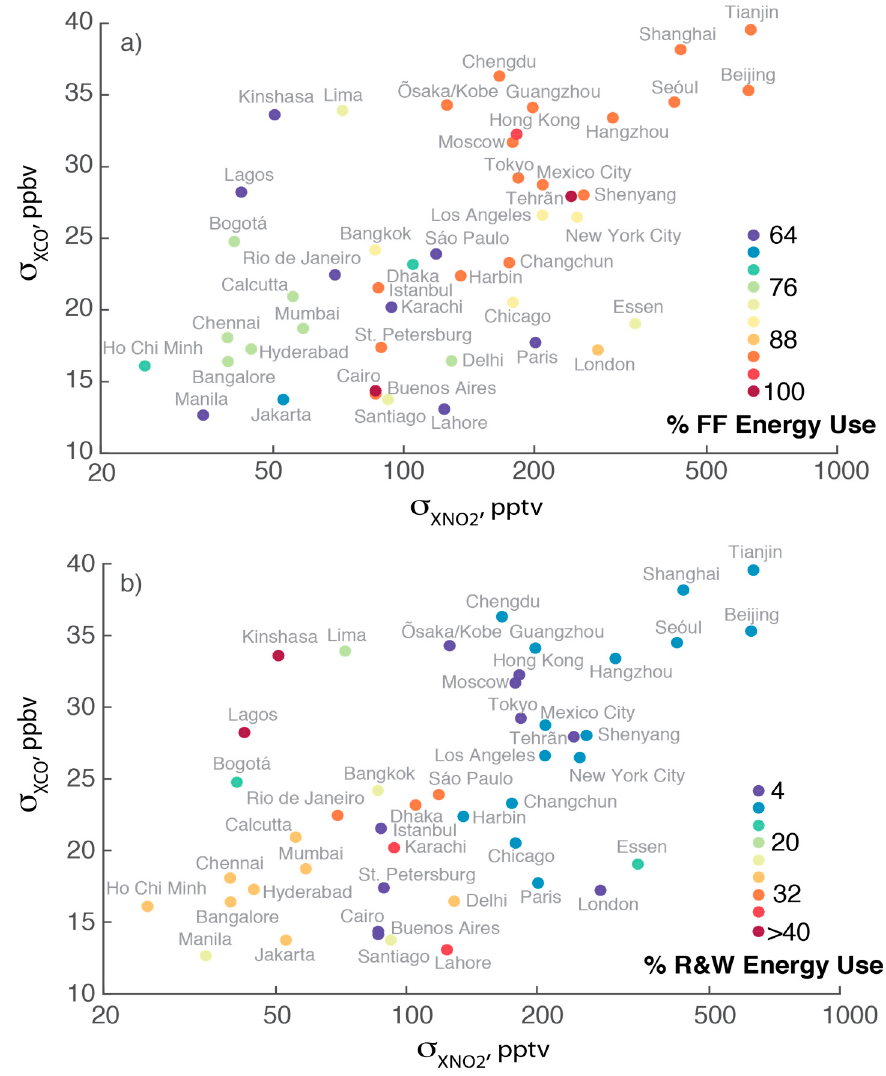
Figure 5. WBDI percent fossil-fuel energy use versus combustible ( a ) and renewable and waste consumption ( b ) across 46 megacities as a function of XCO and XNO 2 spread for the year 2010.